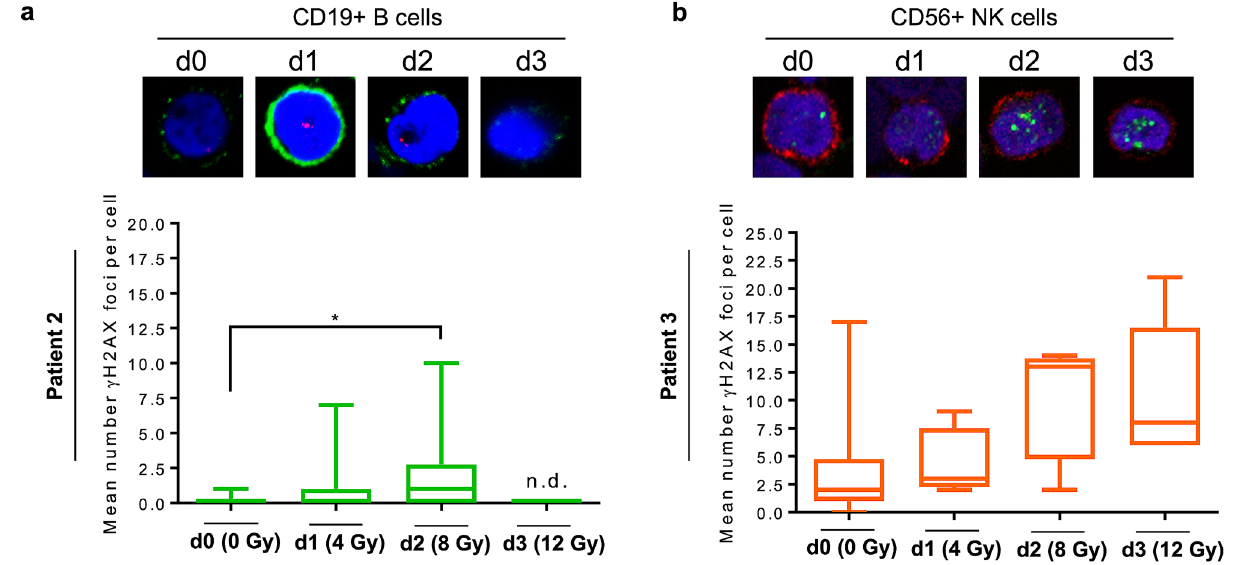
Figure 6. Quantification of γH2AX foci in ( a ) CD19+ B cells (CD19, green; γH2AX, red) and ( b ) CD56+ NK cells (CD56, red; γH2AX, green) of patients following total body radiation. Representative images are shown. ( a ) B cells: 20 CD19+ B cells were quantified per sample. No CD19+ B cells could be found on the slide at d3 (n.d., not detectable). In general, there were only small amounts of γH2AX foci induced in B cells, with a maximum of 1 focus per cell at day 2 (t-test, * p < 0,05). ( b ) NK cells: At d1, d2 and d3 only very low numbers of CD56+ NK cells could be found on the slides because of high cytotoxicity. The surviving cells showed an increase of γH2AX foci with cumulative